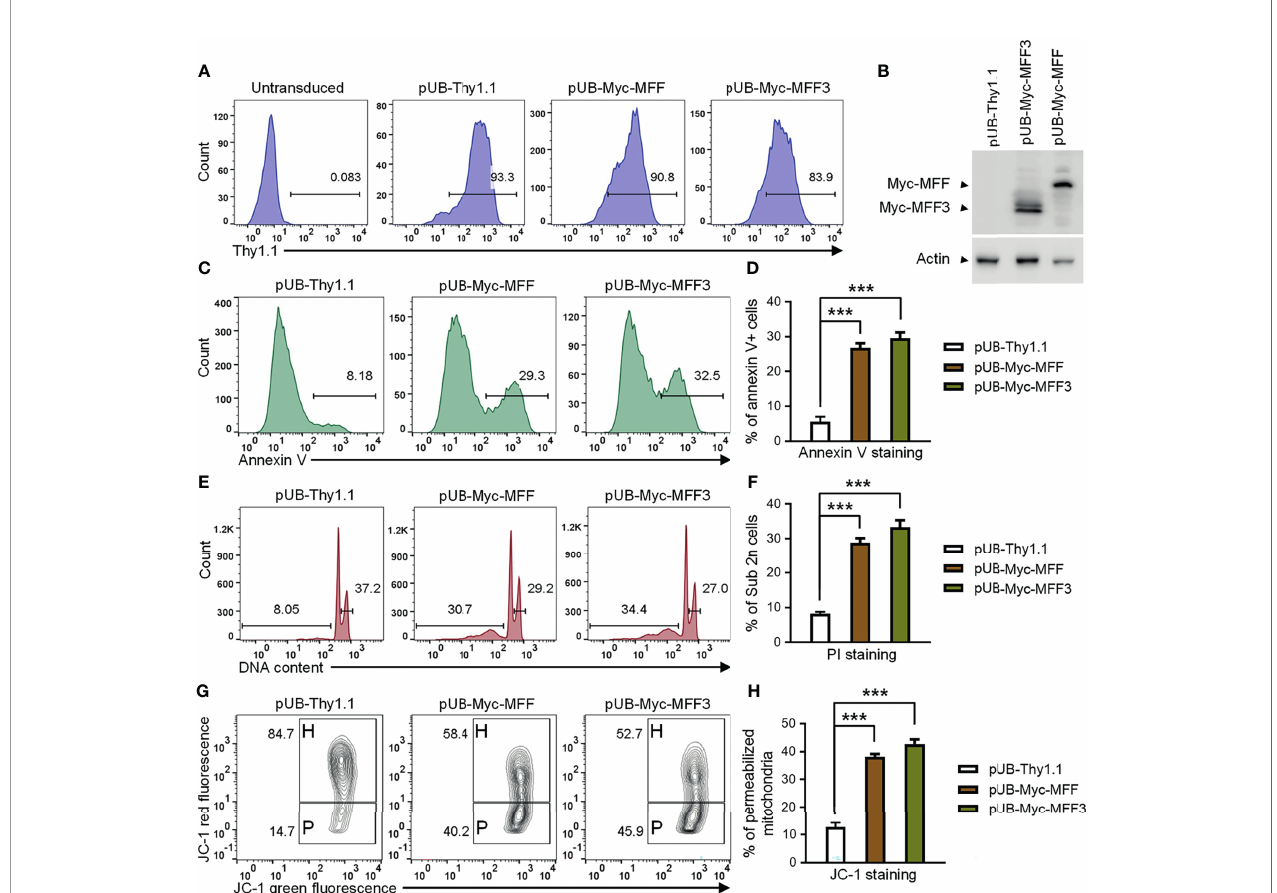
FIGURE 7 | Overexpression of MFF induced mitochondria-dependent apoptosis in human MM 8226 cells. Cells were transduced with individual lentiviral expression vector of MFF (pUB-Myc-MFF), MFF3 (pUB-Myc-MFF3), or an empty vector (pUB-Thy1.1). (A) Transduction ef fi ciency of 8226 cells analyzed by Thy1.1 immuno fl uorescence staining and FACS. Cells were analyzed at day 3 post transduction. Gated population (Thy1.1+) indicates the cells that were successfully transduced with the lentiviral expression vector. (B) Ectopic overexpression of MFF and MFF3 in transduced 8226 cells. Total cellular proteins were prepared at day 4 post transduction, and then immunoblotted for the Myc tag, followed by actin. Bands of Myc-MFF and Myc-MFF3 are indicated in the fi gure. (C – H) Cell apoptosis, DNA fragmentation and mitochondrial membrane permeabilization were analyzed at day 6 post transduction. (C) Representative FACS pro fi les of annexin V staining. Gated populations indicate the annexin V+ apoptotic cells. (D) Graphical results of the percentage of annexin V+ apoptotic cells. (E) Representative FACS pro fi les of cell cycle analysis by PI staining. Gated populations indicate apoptotic cells with DNA fragmentation (DNA content < 2n) and proliferating cells (2n < DNA content ≤ 4n). (F) Graphical results of the percentage of apoptotic cells with DNA fragmentation. (G) Representative FACS pro fi les of mitochondrial membrane permeabilization measured by MitoProbe JC-1 staining. Gated populations in H show cells with healthy mitochondria and gated populations in P indicate cells with permeabilized mitochondria. (H) Graphical results of the percentage of cells with permeabilized mitochondria. (D, F, H) The graphs depict the results of 3 independent experiments with duplicate samples in each experiment (mean ± SD). *** p < 0.001 by one-way